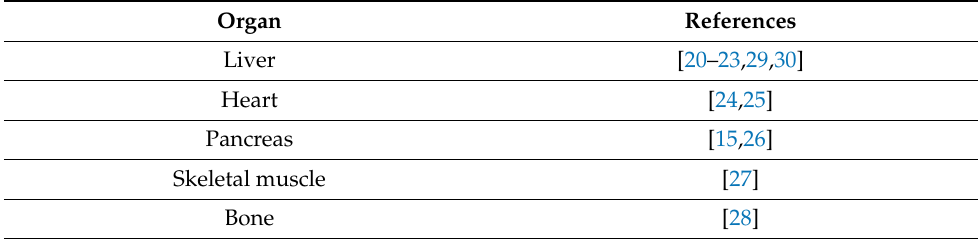
Table 4. References for the organ sources of cells lysed with Solution C and